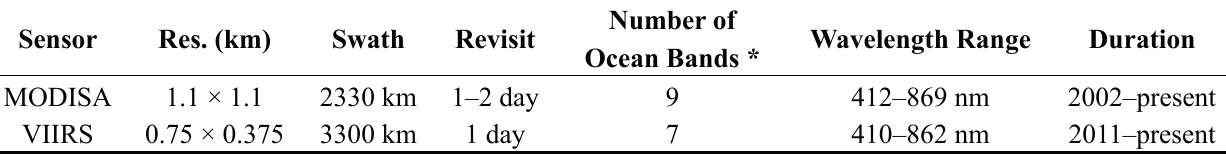
Table 1. MODIS and VIIRS sensor